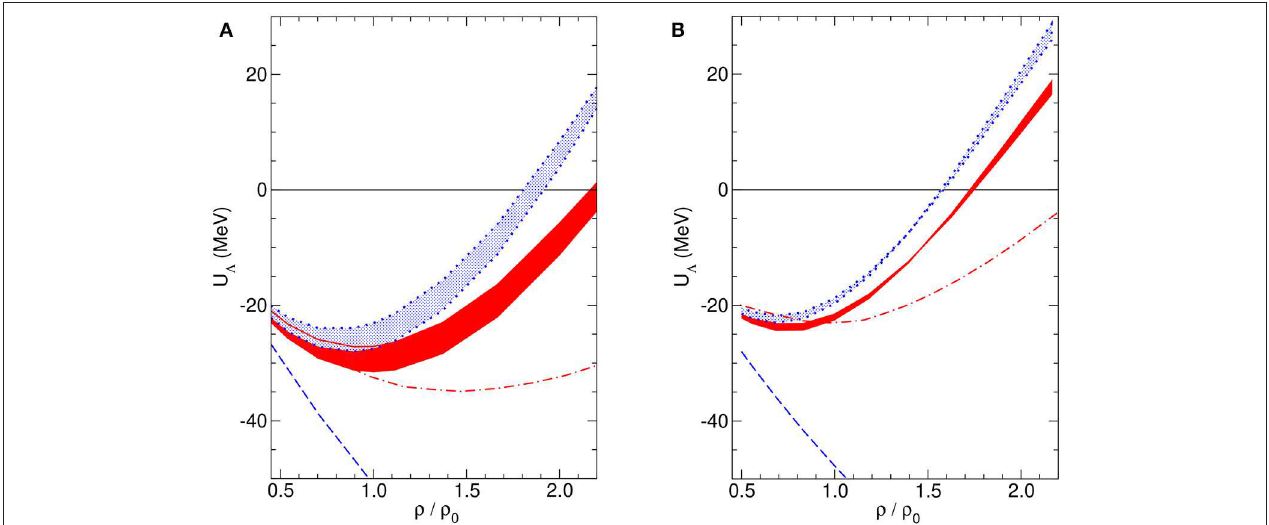
FIGURE 19 | The 3 single-particle potential U 3 ( p 3 0, ρ ) as a function of ρ/ρ 0 in symmetric nuclear matter (A) and in neutron matter (B) . The solid (red) band shows = the chiral EFT results at NLO for cutoff variations 3 450 500 MeV. The dotted (blue) band includes the density-dependent 3 N -interaction derived from the 3 NN = − three-body force. The dashed curve is the result of the Jülich ’04 meson-exchange model [ 21], the dash-dotted curve that of the Nijmegen NSC97f potential [20], taken from Yamamoto et al. [